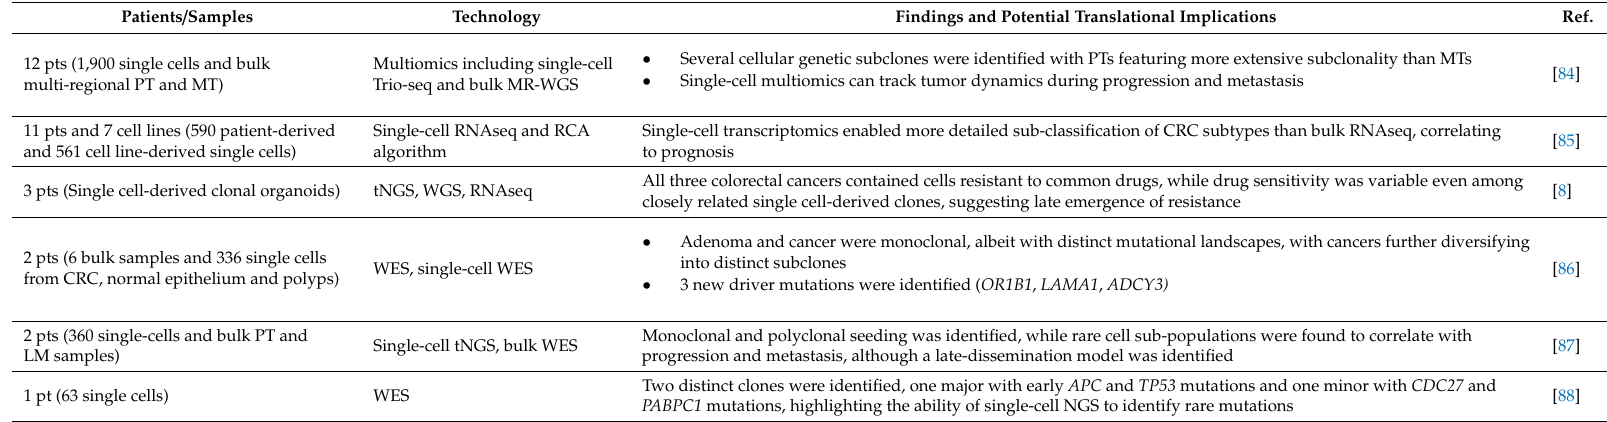
Table 5. Cell-to-cell heterogeneity and drug response